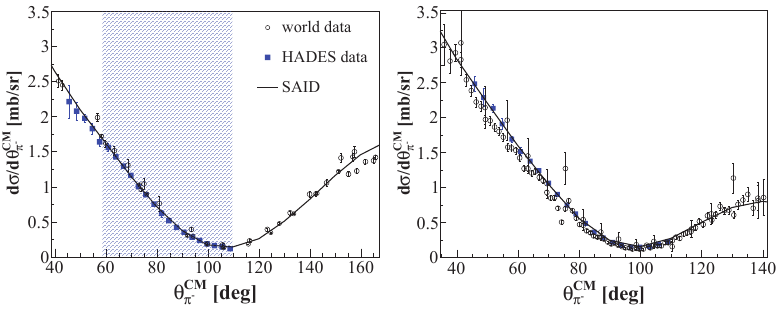
Figure 1. ( π − p elastic-scattering cross section at a beam momentum 656 (left panel) and 800 MeV / c (right panel). The HADES data (blue squares) are presented together with the world data and the current SAID solutions [8]. The marked area in the left panel refers to the region used for the